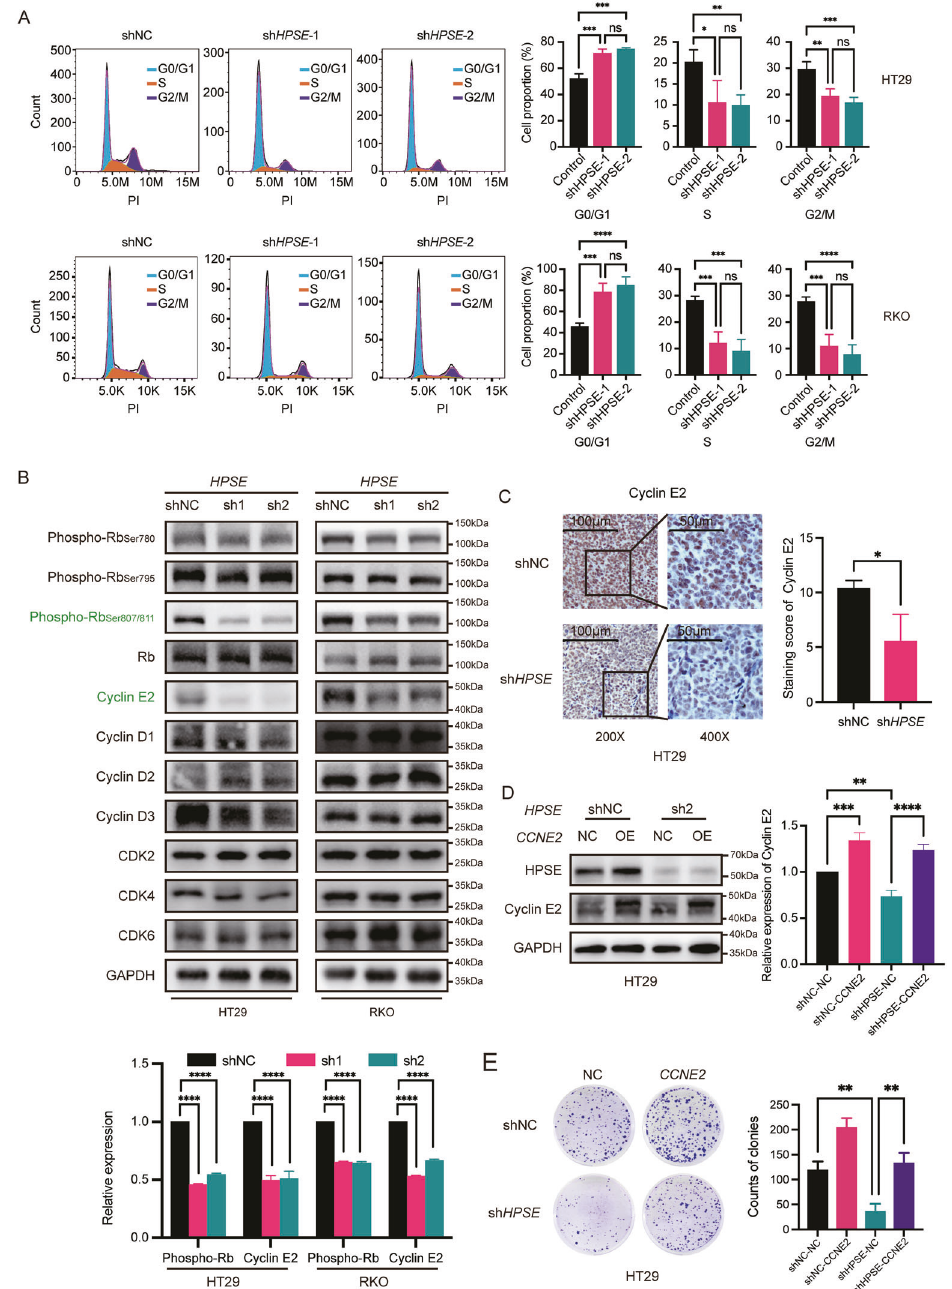
Fig. 4 Silencing HPSE arrests cell cycle of BRAF V600E-mutant CRC cells by downregulating Cyclin E2 expression. A Cell cycle distributions and statistical analysis of HT29 and RKO with or without HPSE silencing. The same trend was observed in three independent repeated experiments. Representative images and statistical analysis of cell cycle distribution are shown. Data are presented as the mean ± standard deviation. B Expressions of critical cell cycle-related proteins in BRAF V600E-mutant CRC cells with or without HPSE silencing. The same trend was observed in three independent repeated experiments. Green color represents downregulated proteins. Representative results and semi- quanti fi cation analysis are shown. Data are presented as the mean ± standard deviation. C IHC staining of Cyclin E2 in subcutaneous tumor tissues. Representative results and semi-quanti fi cation analysis are shown. Data are presented as the mean ± standard deviation. D Veri fi cation of CCNE2 overexpression in HPSE- knockdown HT29 at the protein level. The same trend was observed in three independent repeated experiments. Representative results and semi-quanti fi cation analysis are shown. Data are presented as the mean ± standard deviation. NC negative control. OE overexpression of CCNE2 . E Representative images and statistical analysis of colony formation assay. Cells were seeded in six-well plates at 1000 cells per well and cultured for 10 days. The same trend was observed in three independent repeated experiments. Data are presented as the mean ± standard deviation. The student ’ s t -test was used to determine the P -value in two-group comparisons. One-way ANOVA analysis and Tukey ’ s test were used for multiple comparisons. **** P < 0.0001, *** P < 0.001, ** P < 0.01, * P < 0.05, ns P >